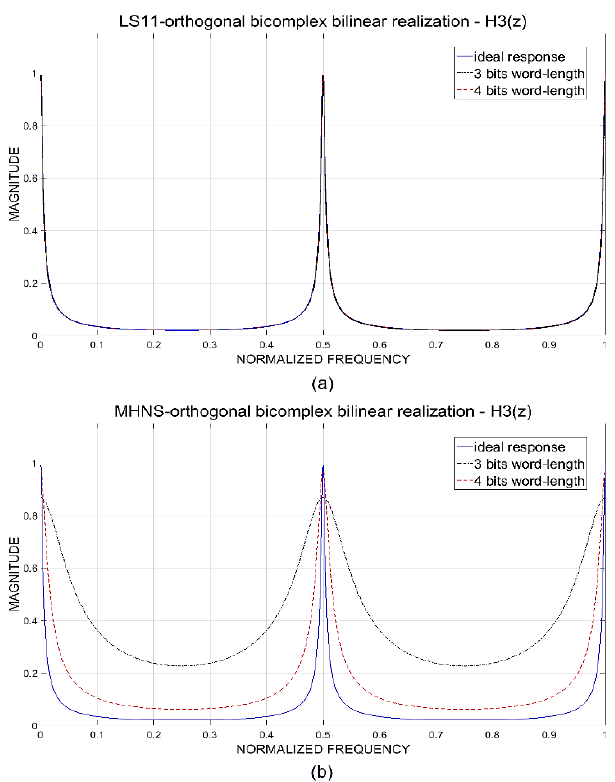
Fig. 10. Magnitude responses of the bicomplex orthogonal real-coefficient functions H 3 ( z ) for different word-lengths: (a) LS 11-based; (b) MHNS